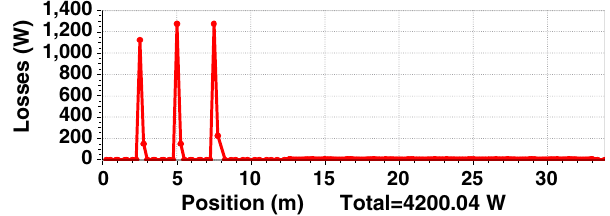
FIG. 14. Power loss distribution for the beam with 0.1% halo (about 1.3 kW for each collimator). No power loss in the VDS section.